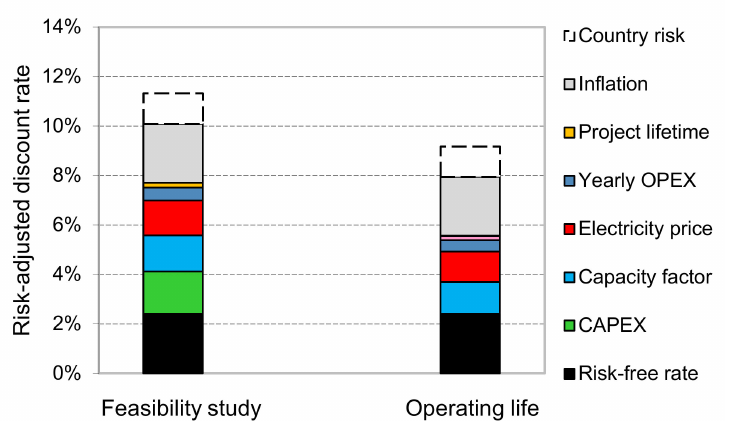
Figure 4. Key risk components of the risk-adjusted discount rate for Polish onshore wind projects at different development